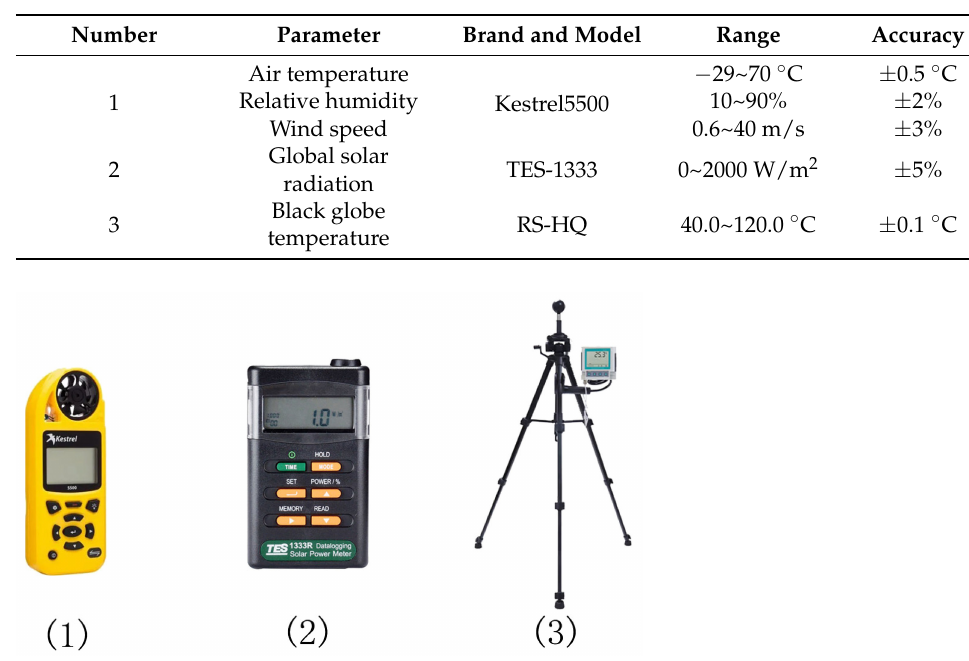
Table 2. Information on experimental equipment.